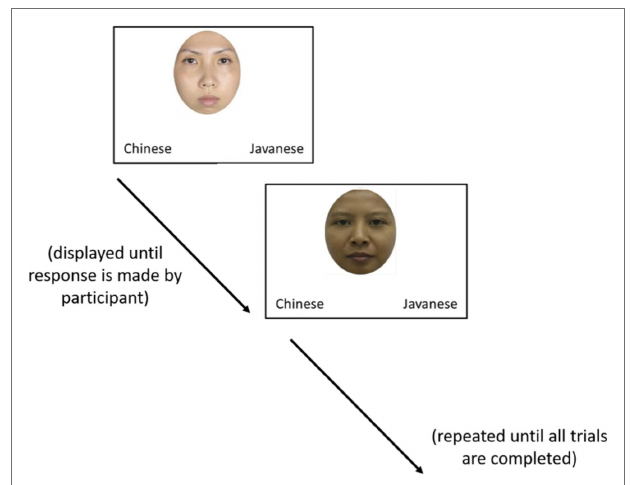
FIGURE 2 | Diagram of experimental setup. Figures reproduced from Nanyang facial emotional expression [N-FEE] database (Yap, Chan, and Christopoulos,